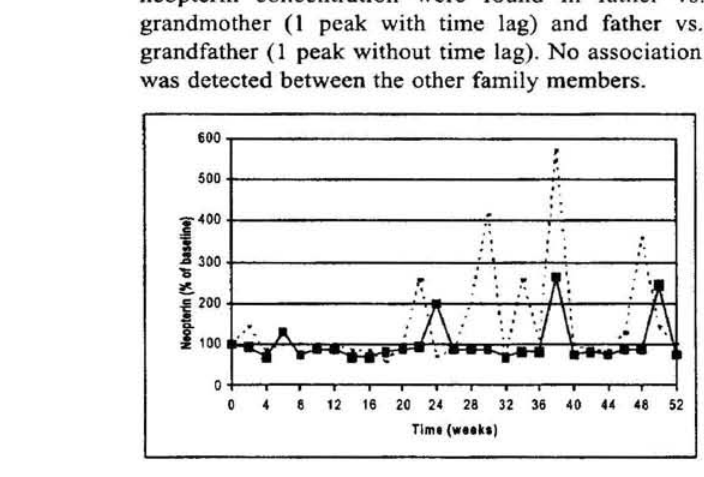
Figure 3: Comparison of urinary neopterin concen- tration in mmol neopterin/mol Creatinine and expressed as %-change from baseline in the child (bro- ken line) and her father (through line). PteridinesA^ol. !4/No.